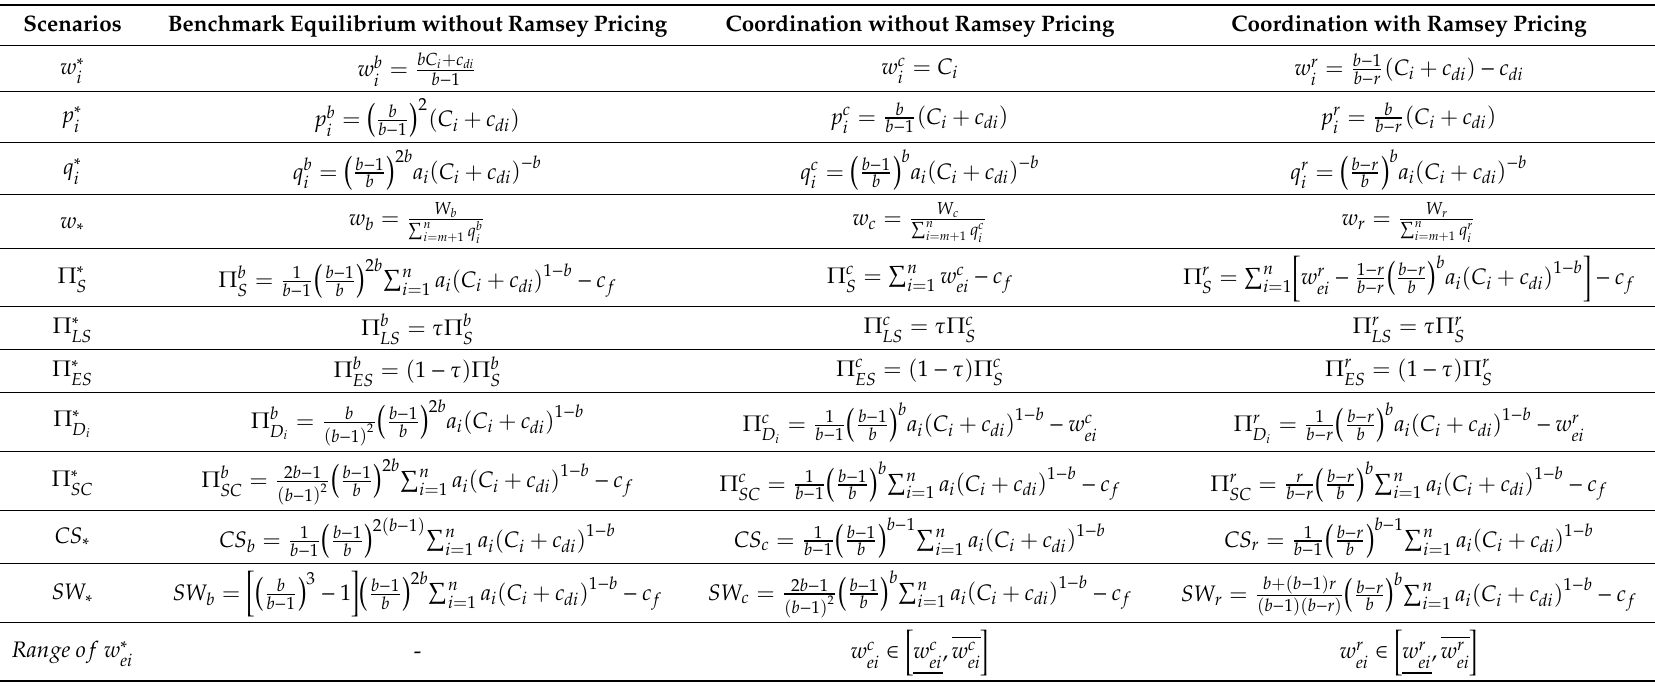
Table 1. Analytical Results of IBWT Supply Chain Coordination with Ramsey